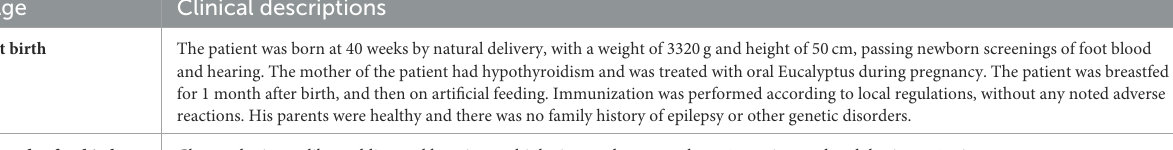
TABLE 1 Disease timeline and therapeutic